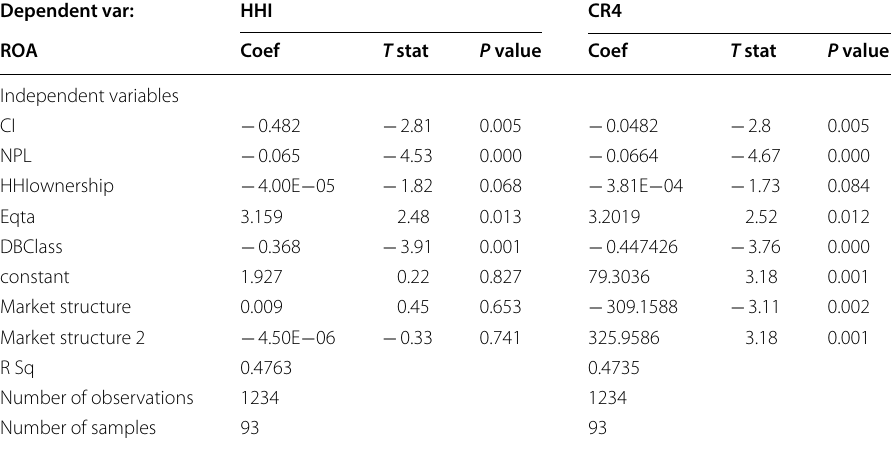
Table 6 Regression result for the relationship between market structure and